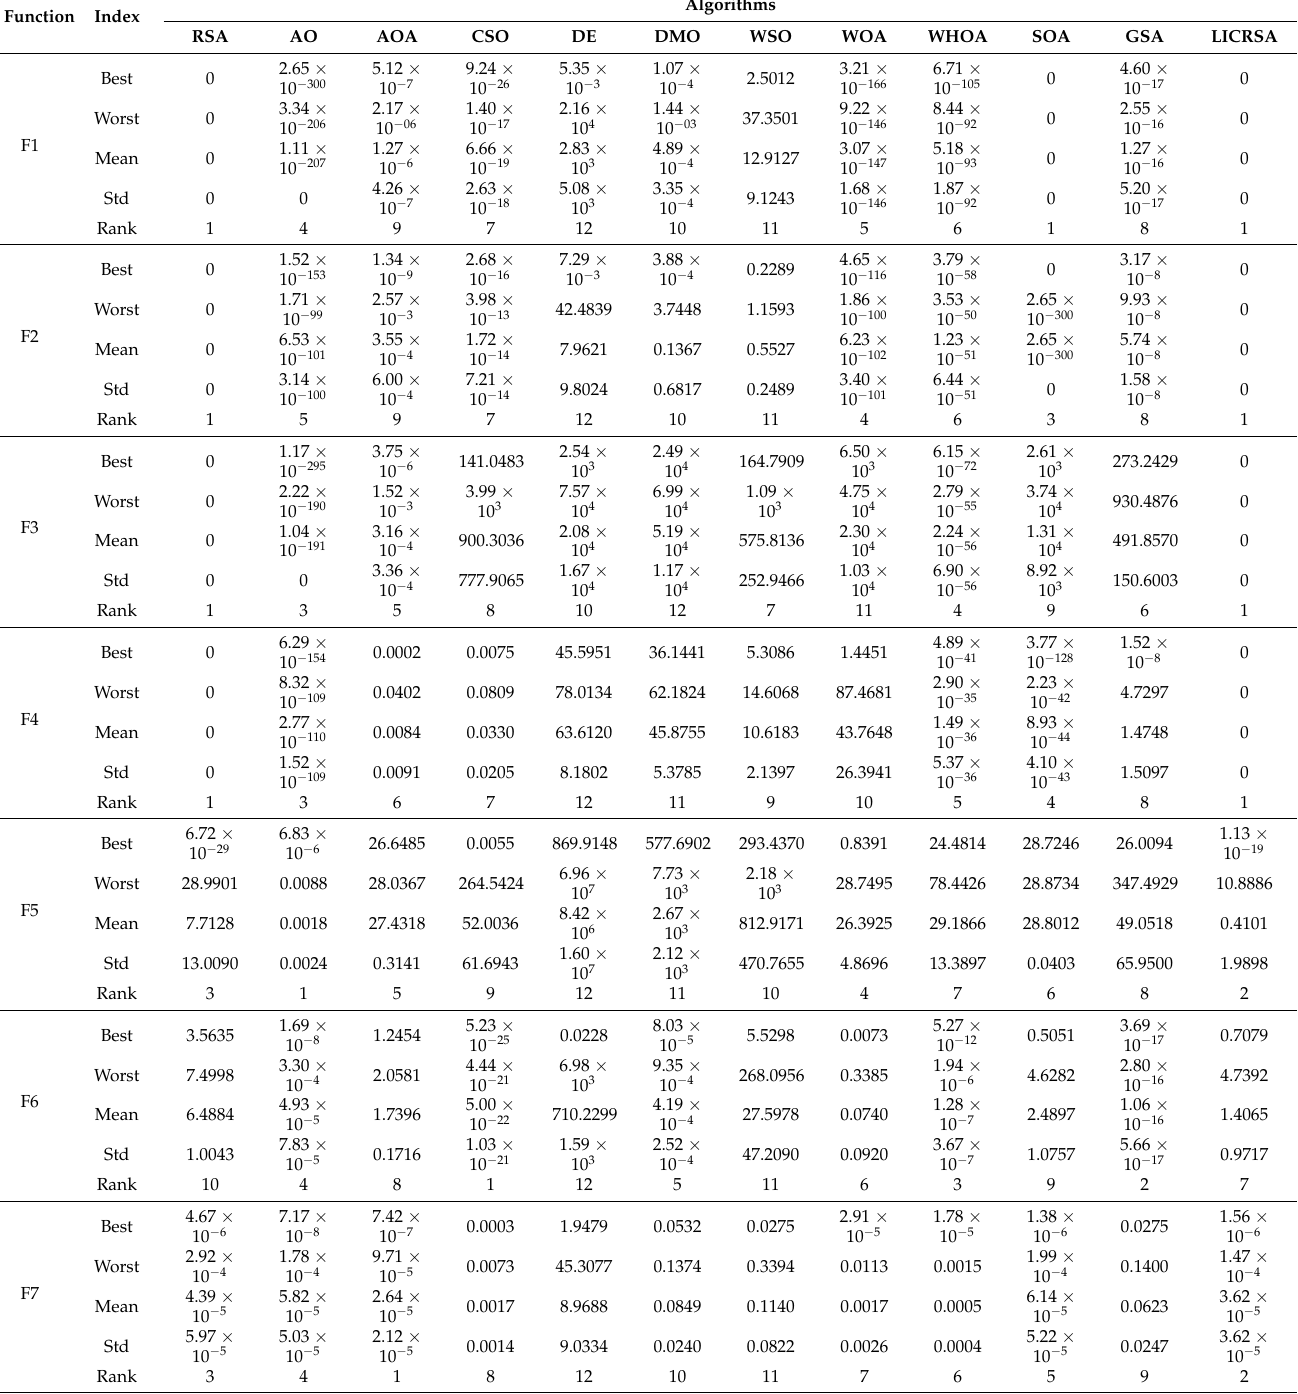
Table 2. Numerical results for best, worst, mean, std of the search algorithm in 12 of the 23 bench- mark